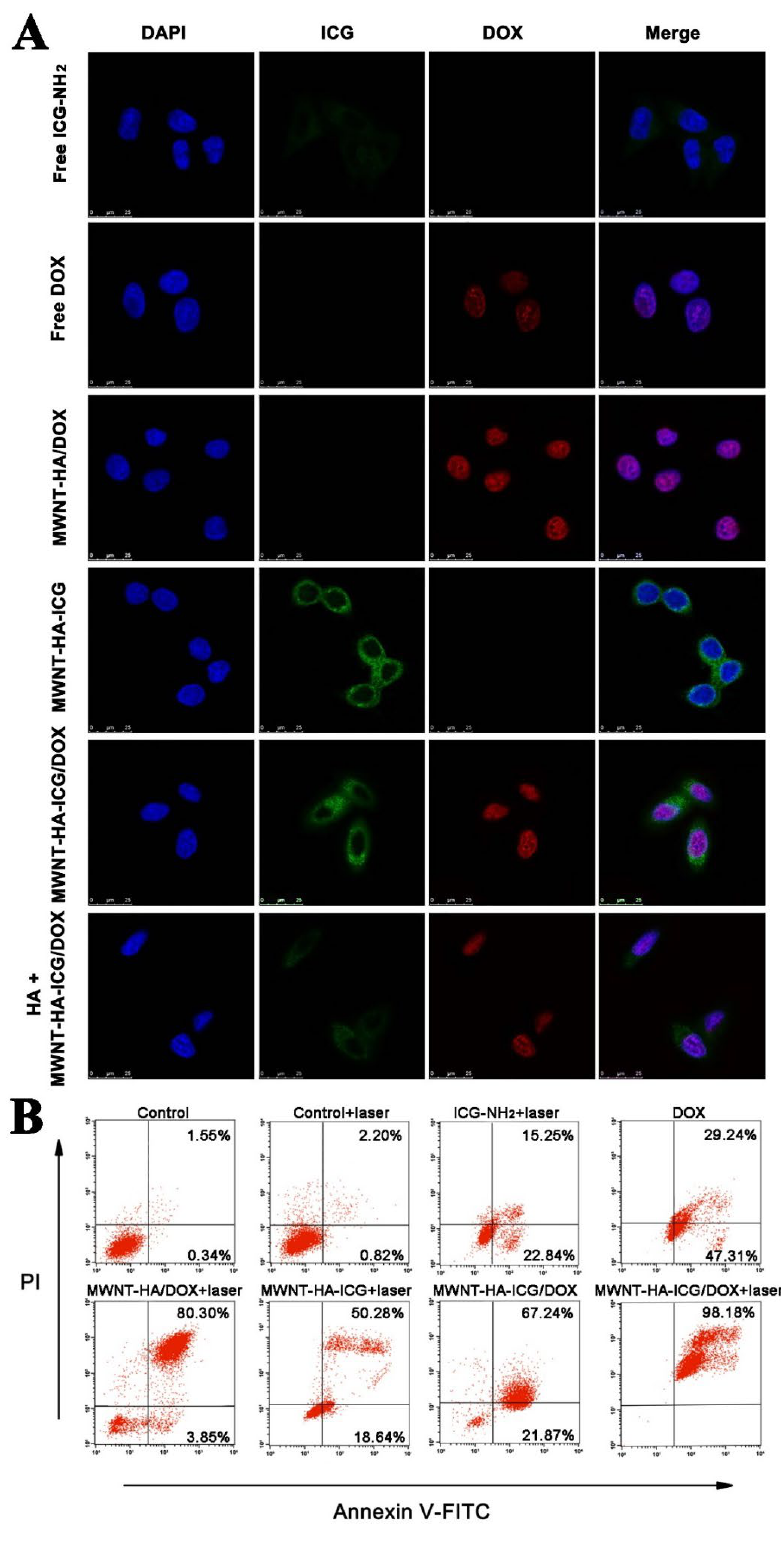
Figure 5. ( A ) Representative confocal images of intracellular trafficking of ICG-NH 2 , DOX, MWNT- HA/DOX, MWNT-HA-ICG, MWNT-HA-ICG/DOX, and MWNT-HA-ICG/DOX pretreated with HA in MCF-7 cells. Nucleus stained by DAPI showed blue fluorescence, ICG showed green fluorescence, and DOX showed red fluorescence. ( B ) Cell apoptosis induced by different formulations with and without laser irradiation using flow cytometry analysis. Cells treated with PBS were used as